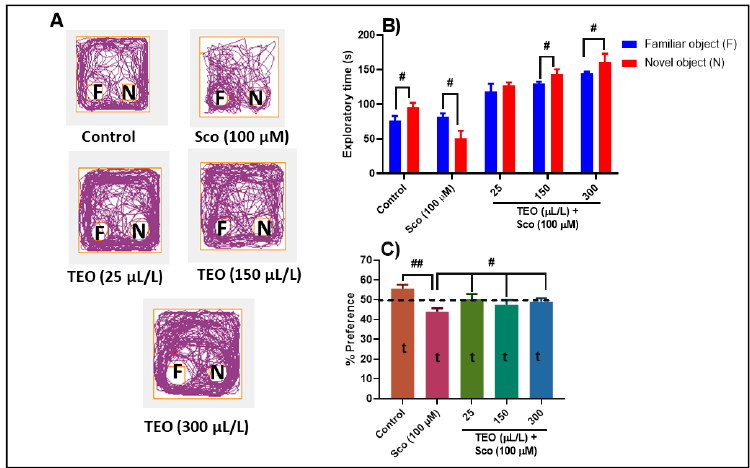
Figure 4. Thymus vulgaris essential oil (TEO: 25, 150, and 300 µL/L) improved memory in the novel object recognition (NOR) test. ( A ) Representative locomotion tracking pattern of the control, scopolamine (Sco: 100 µM), and TEO (25, 150, and 300 µL/L) treated groups; ( B ) Represent the exploratory time in different groups; ( C ) Represent the percentages of preference in different groups. Values are means ± S.E.M. ( n = 10). For Tukey’s post hoc analyses: ( B ) # p < 0.01; ( C ) Control vs. Sco (100 µM): ## p < 0.001, Sco vs. TEO (25 µL/L): # p < 0.01, Sco vs. TEO (150 µL/L): # p < 0.01, and Sco vs. TEO (300 µL/L): # p < 0.01.